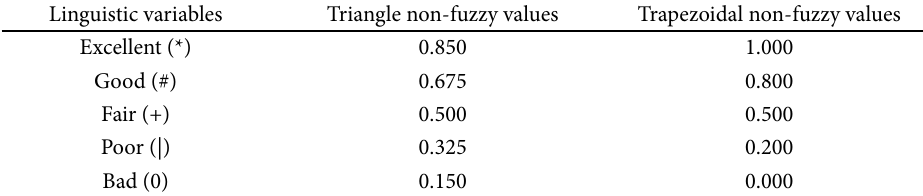
Table 1. Conversion of linguistic variables and QWs symbols into non-fuzzy values linguistic